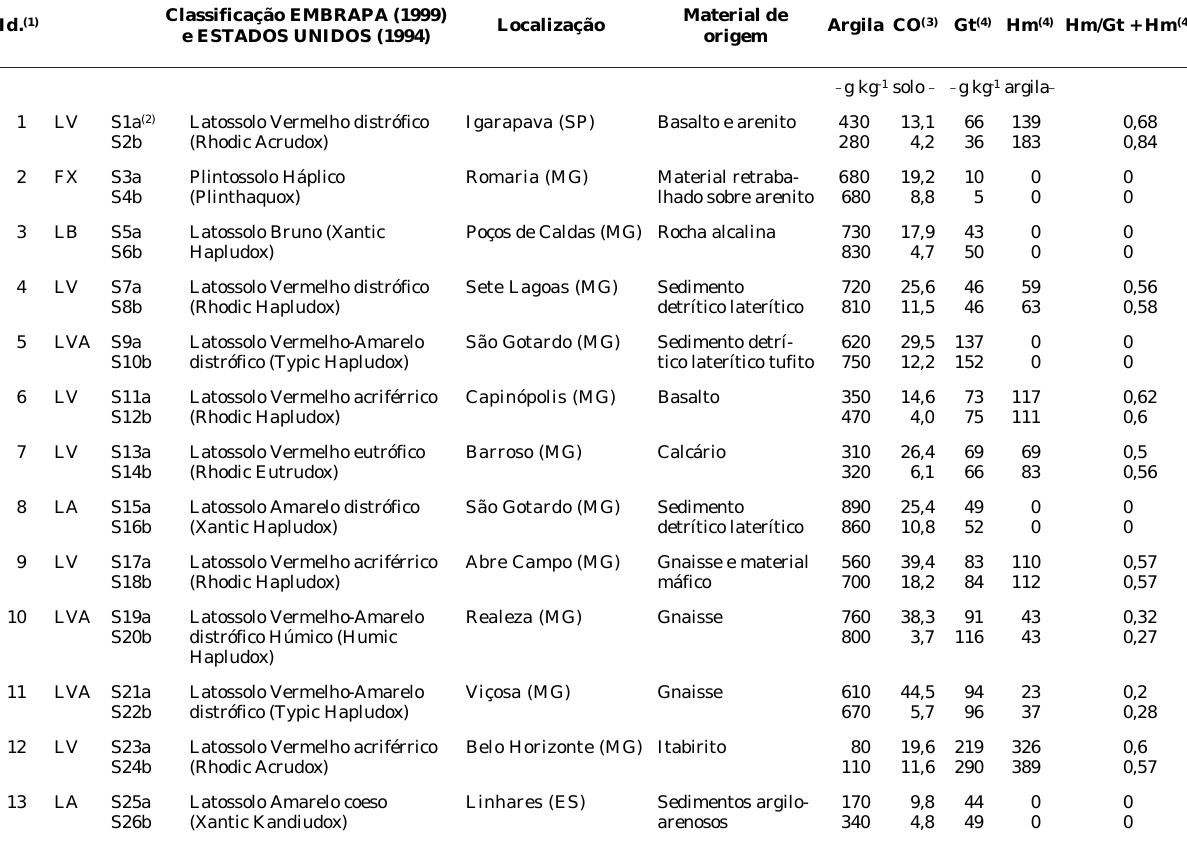
Quadro 1. Identificação dos locais de coleta das amostras e características dos solos